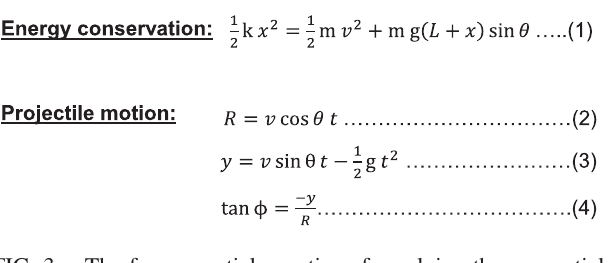
FIG. 3. The four essential equations for solving the sequential synthesis problems.